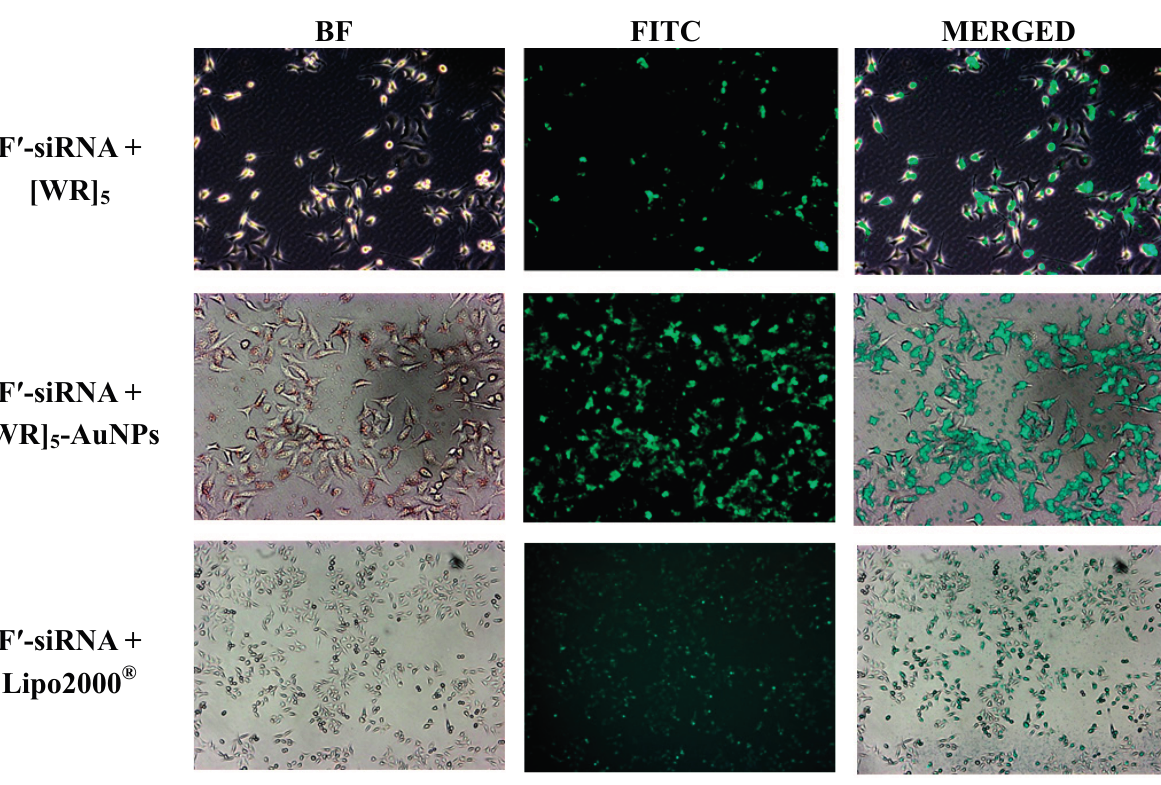
Figure 3. Fluorescence microscope images of F ′ -siRNA uptake by HeLa cells in the presence of [WR] and [WR] -AuNPs after 4 h incubation. No green fluorescence was observed in 5 5 the presence of F ′ -siRNA alone. BF: Brightfield, FITC: Fluorescein isothiocyanate. BF FITC